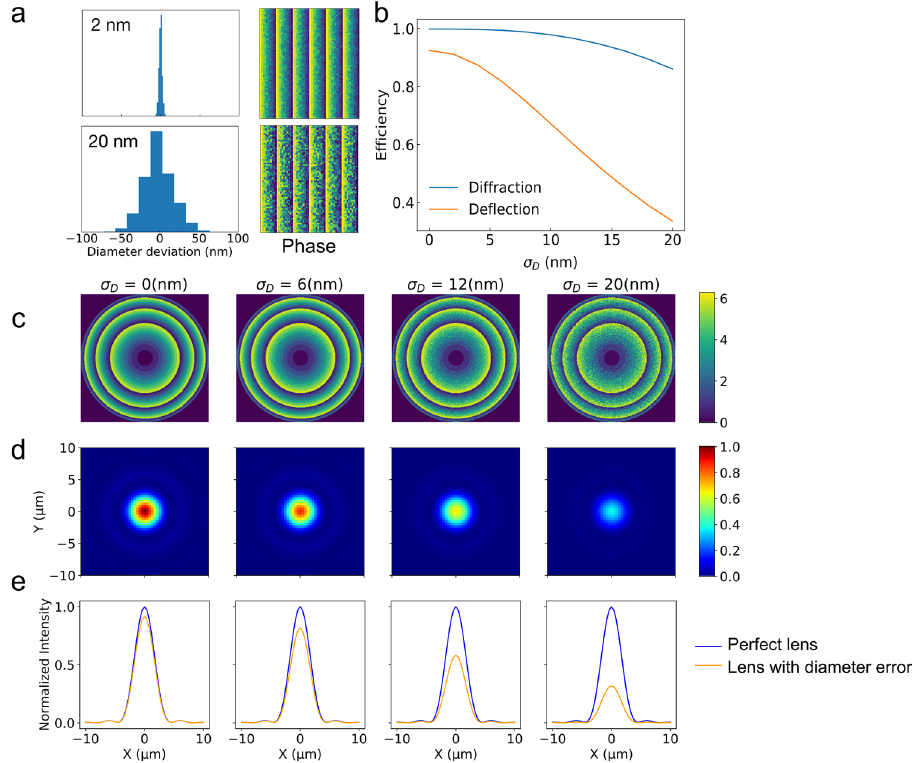
Figure 8. ( a ) Statistical distribution of diameter change (left) and corresponding map of the dephasing induced by the metadeflector (right) for two different values of σ D . ( b ) Deflection and diffraction efficiency of a 100 × 100 µ m 2 metadeflector as a function of the standard deviation on the nanocylinder diameters. The metadeflector nominal supercell is the same as before. ( c ) Map of the dephasing induced by a metalens (diameter 100 µ m , focal distance 500 µ m ) for different values of σ D . ( d ) Corresponding intensity distribution in the focal plane. (e) Brown line: Transverse intensity profile in the focal plane of the metalens. Blue line: case of a perfect